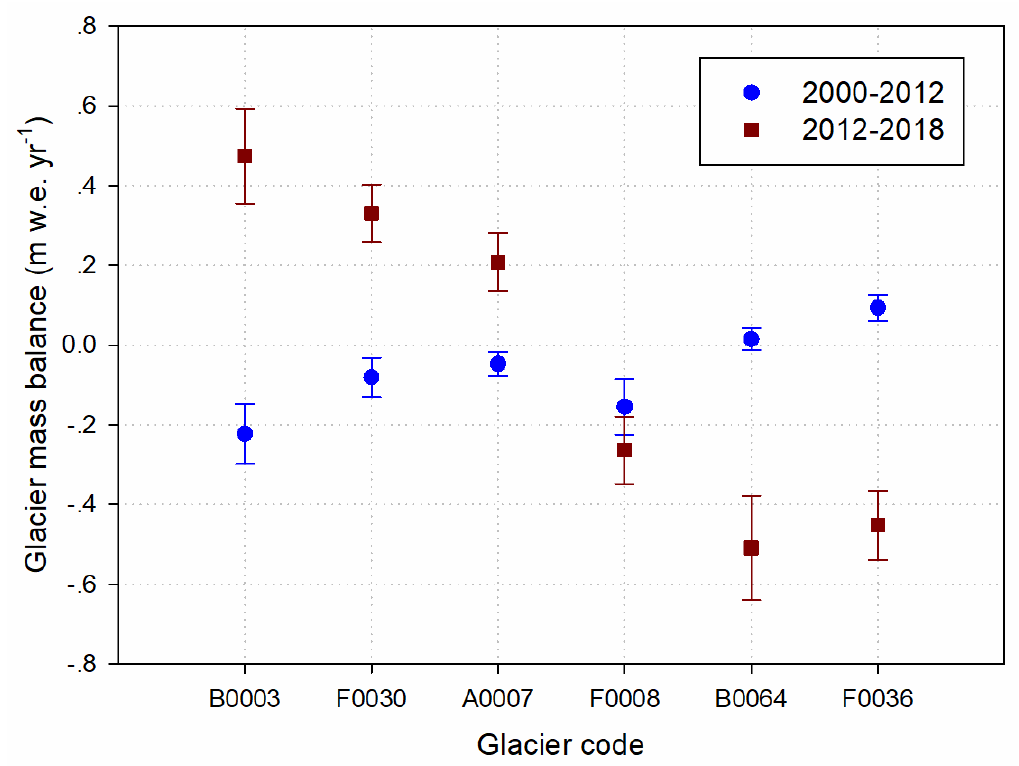
Figure 5. Comparison of the estimated glacier mass balances between 2000 − 2012 and 2012 − 2018 over the six surge-type glaciers in the GLDDM. The WGMS IDs of these glaciers are depicted as the last five codes.